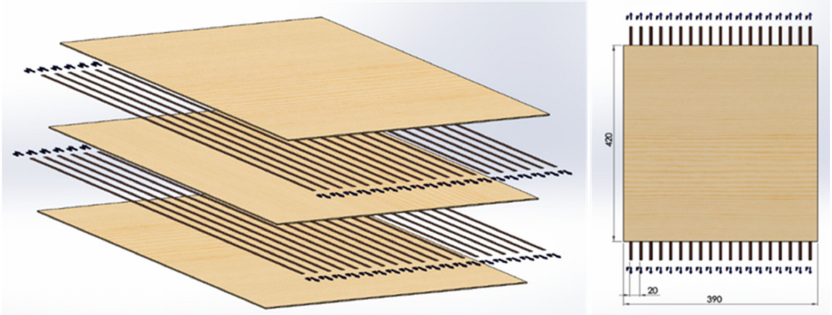
Figure 1. Exploded ( left ) and top view ( right ) of the 3-layer plywood test panels used in this study.